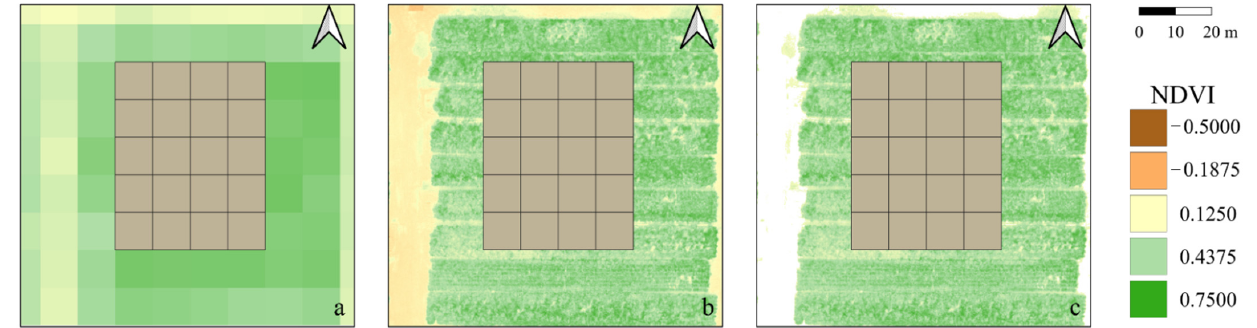
Figure 9. ROI E-20 polygons used to sample regions throughout the east field for December across Sentinel-2 data ( a ), UAS soil-inclusive data ( b ), and UAS soil-exclusive data ( c ). For all other UAS surveys and corresponding Sentinel-2 data collected between Au- gust 2019 and February 2020, a single FWD NDVI model prediction was made for the entire ROI E (i.e., the original 50 m × 40 m region; Figure 8) to illustrate the influence of soil pixels on model predictions across time as soil visibility changes with phenology. FWD predic- tions made with Sentinel-2 data, soil-inclusive UAS data, and soil-exclusive UAS data were compared by MAPE and RMSE.